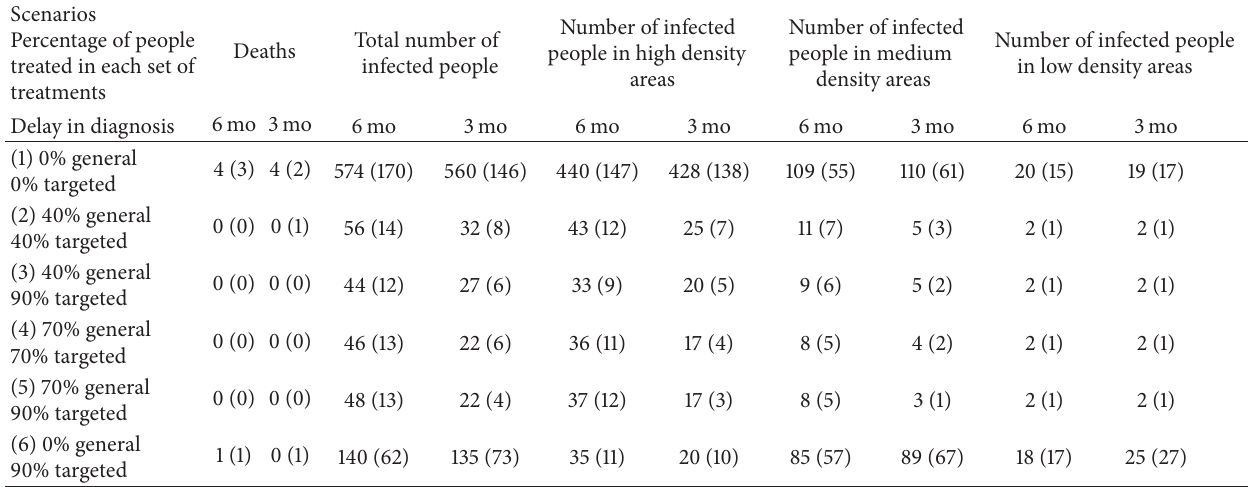
Scenarios Percentage of people treated in each set